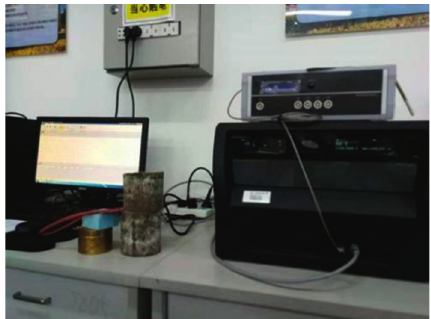
Figure 4: The thermal conductivity test.